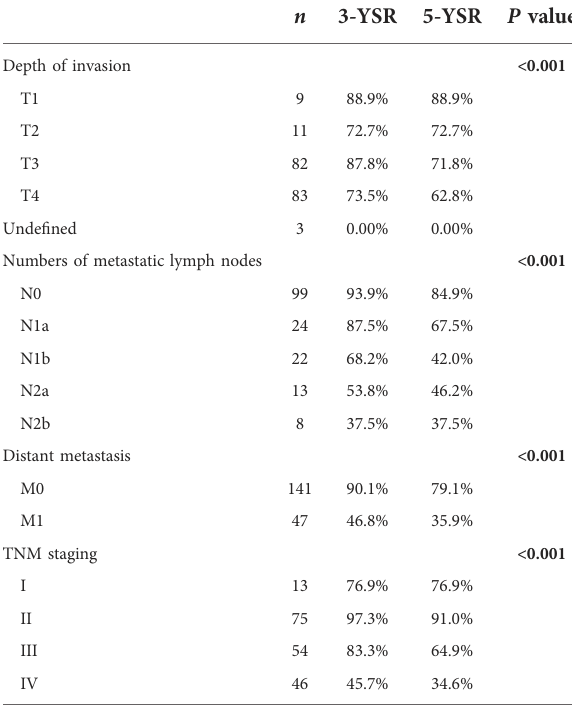
TABLE 3 Univariate analysis of TNM staging for tumor from patients with colon